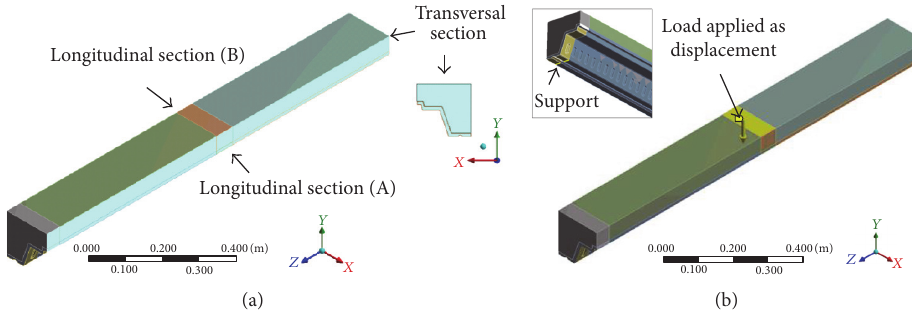
Figure 6: Boundary conditions applied on m - k